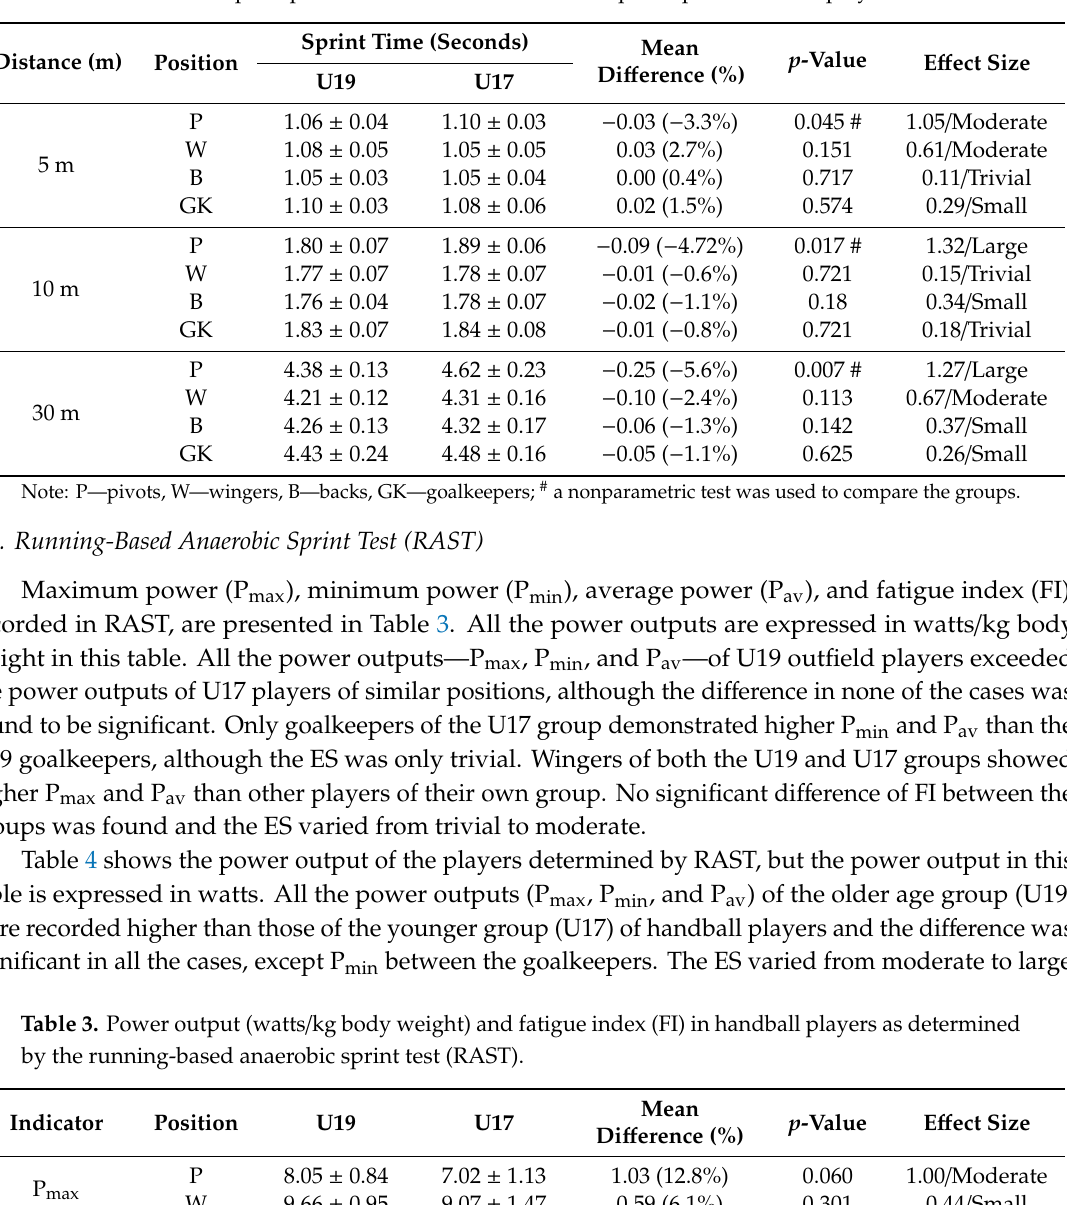
Table 2. Sprint performance of the U17 and U19 participant handball players.